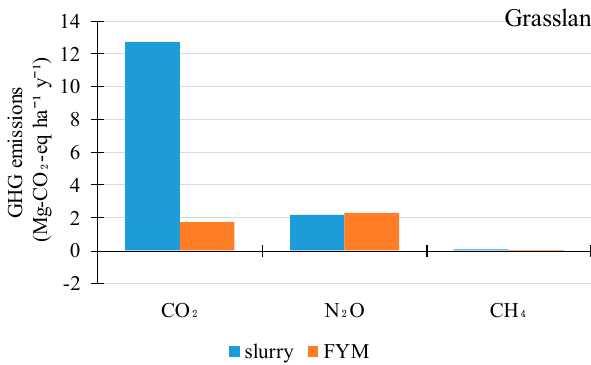
Figure 1. Annualized emissions of CO 2 (NECB), N 2 O and CH 4 from grassland receiving manure + fertilizer.